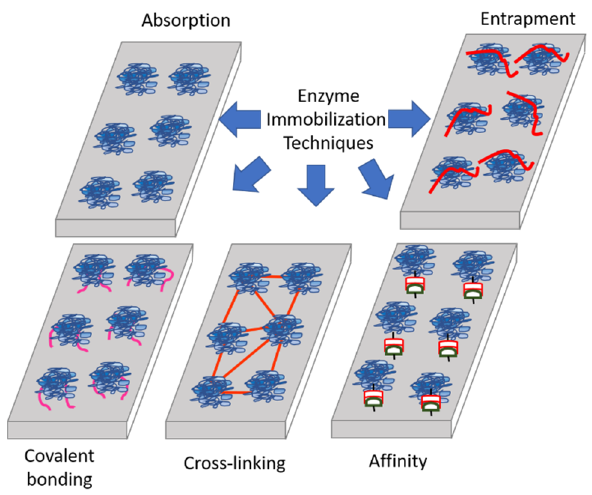
Figure 11. Various enzyme immobilization techniques for enzyme-based biofuel cells (EBFCs).